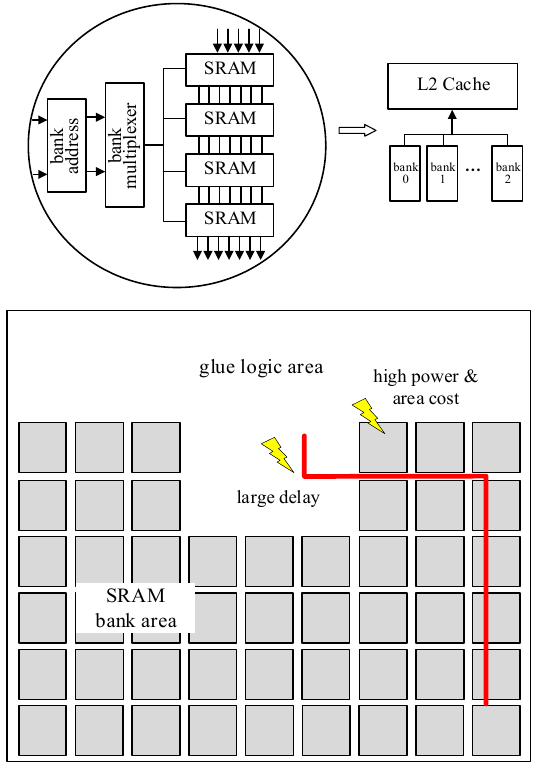
Figure 1. The structure of the on-chip cache.